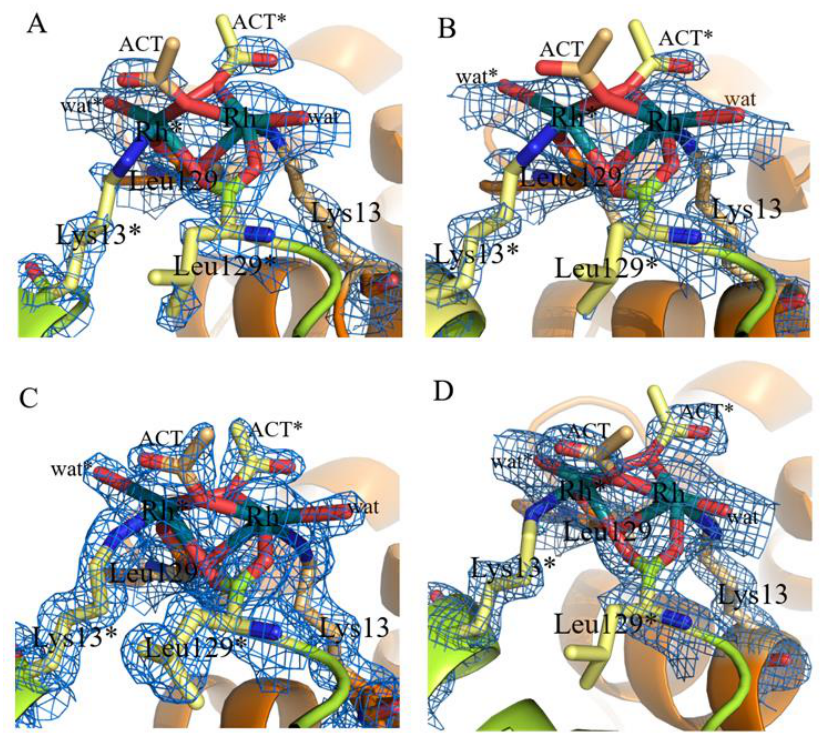
Figure 4. Details of Rh binding sites close to C-terminal tail and the side chain of Lys13 in the Crystals 1–4 (A-D). 2Fo-Fc electron density maps are contoured at 0.7 σ (cyan). An example of 1–4 ( A – D ). 2Fo-Fc electron density maps are contoured at 0.7 σ (cyan). An example of anomalous difference electron density map of this site is reported in Supporting Information (Fig-